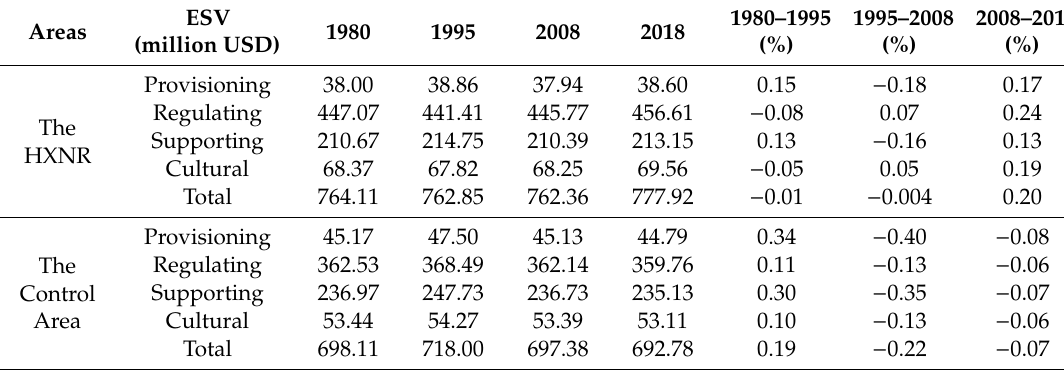
Table 5. Ecosystem service value in the study area during 1980–2018 and the annual rates of change for three periods before and after the establishment of the